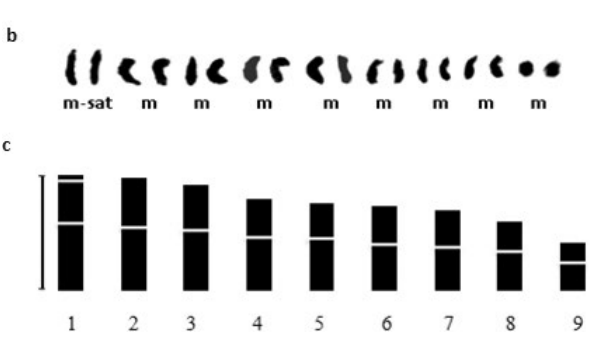
Figure 3. Karyotype of Trifolium subterraneum L. in Algeria. (a) Somatic metaphasis (2n=18, population 23/10); (b) Karyogram; (c) Idiogram; arrow (satellites). Bar: 2µm.